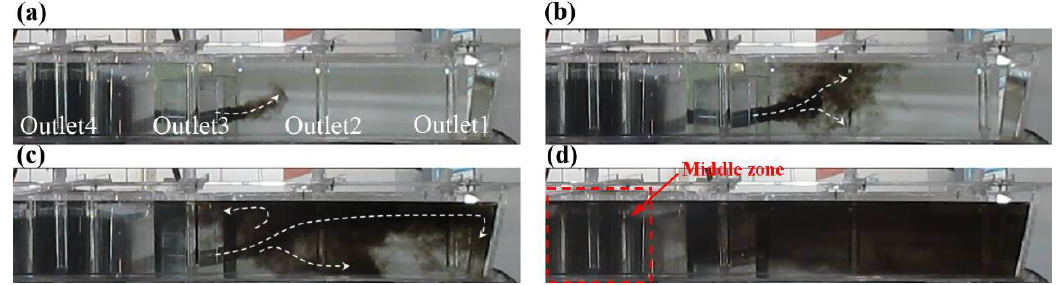
Figure 6. Ink dispersion behavior in the prototype case A0: ( a ) 23 s, ( b ) 38 s, ( c ) 101 s, ( d ) 205 s.